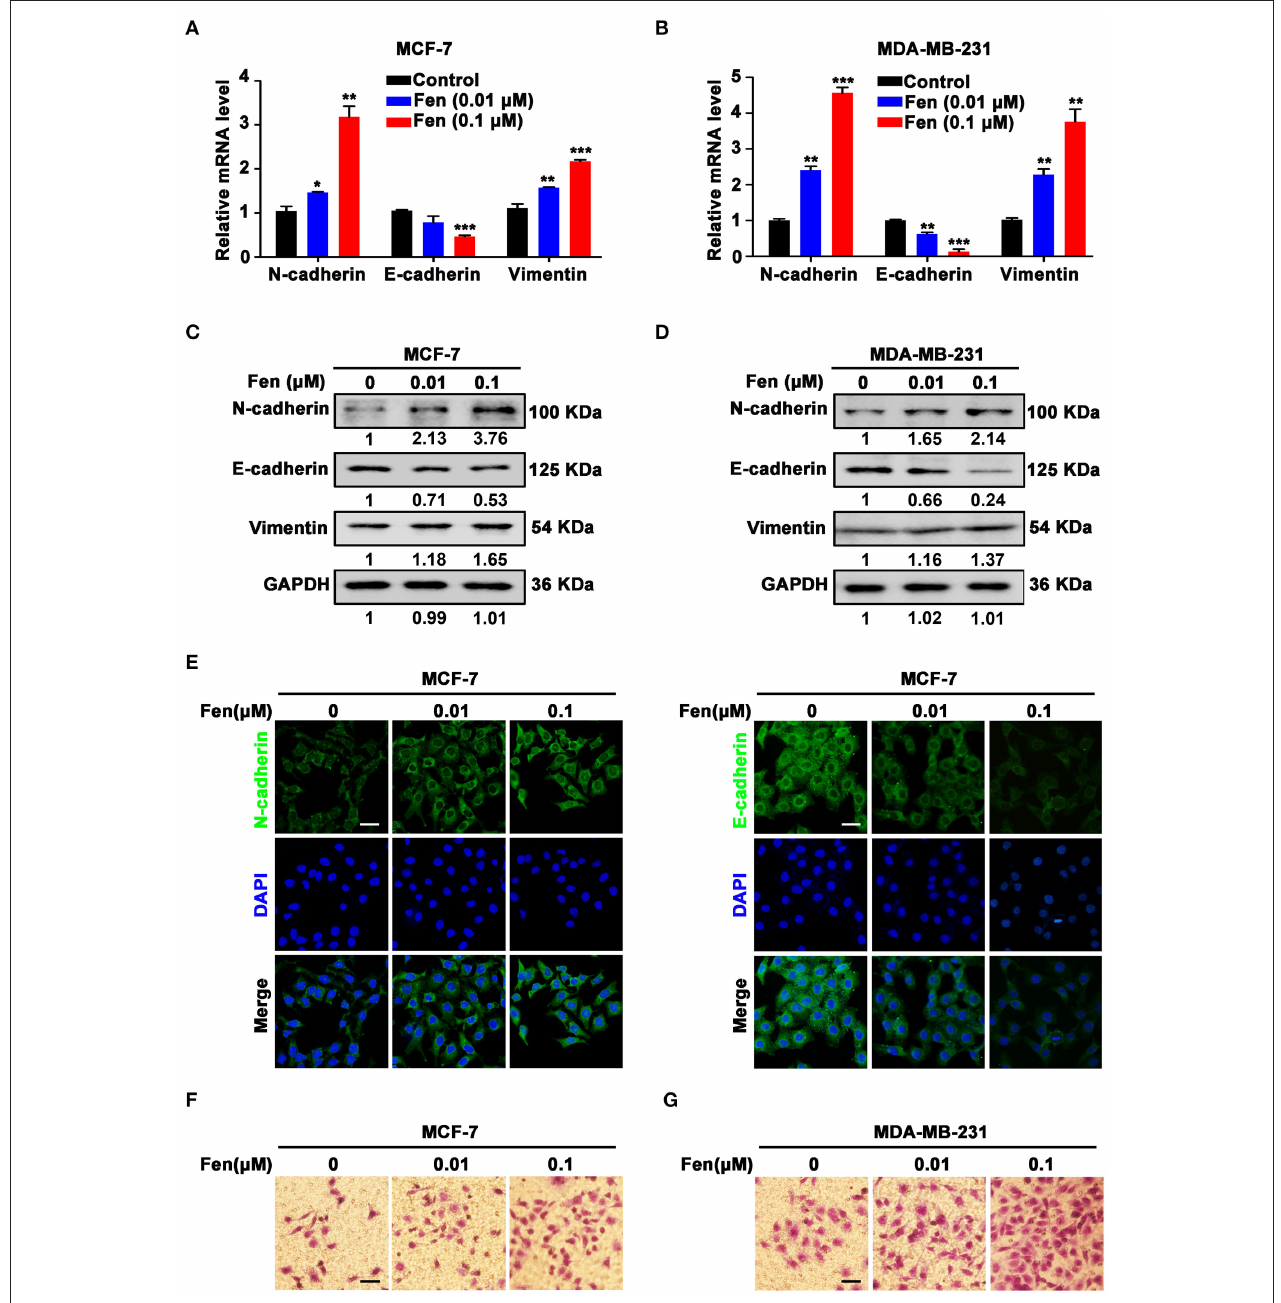
FIGURE 2 | Fentanyl facilitates EMT of breast cancer cells. (A,B) qPCR and (C,D) Western blot analysis of gene and protein expression of N-cadherin, E-cadherin and Vimentin in MCF-7 and MDA-MB-231 cells treated with fentanyl (0, 0.01 µ M, 0.1 µ M) for 48 h. (E) Representative immunofluorescent images of N-cadherin and E-cadherin of MCF-7 cells treated with fentanyl for 48 h. (Scale bars = 50 µ m; Magnification, 200 × ). (F,G) Images of migrated MCF-7 and MDA-MB-231 cells observed under a microscope after fentanyl treatment. (Scale bars = 50 µ m; Magnification, 200 × ). Data are represented as mean ± SD ( n = 3). Statistical significant different in gene expression (* P < 0.05; ** P < 0.01; *** P < 0.001).